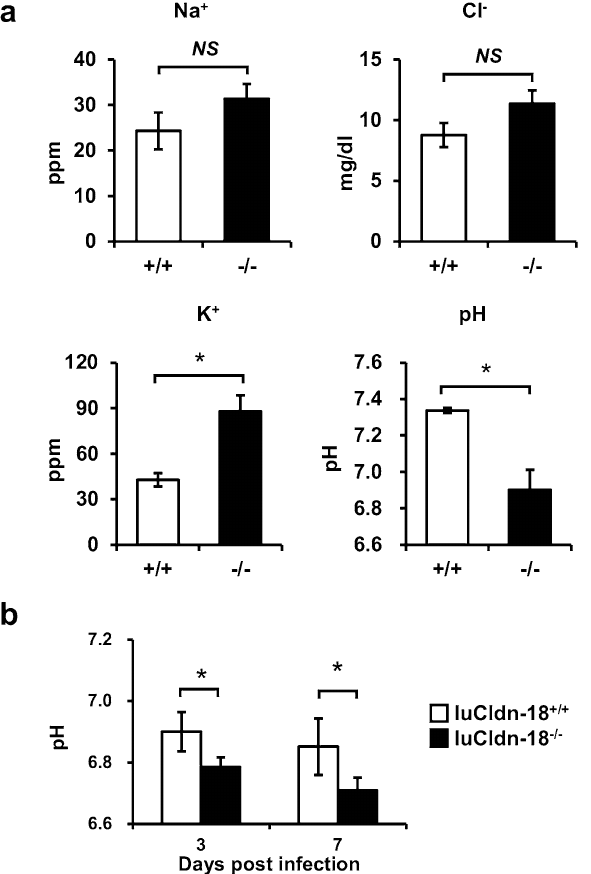
Figure 5. Effects of luCldn-18 deficiency on ion concentration and pH in BALFs. ( a ) The concentrations of several ions (Na + , Cl − , K + ) and pH were measured in BALFs of uninfected luCldn-18 +/+ (n = 3) and luCldn-18 −/− mice (n = 3) . Each column represents the mean ± SD. ( b ) luCldn-18 +/+ (n = 4) and luCldn-18 −/− mice (n = 4) were infected intratracheally with C. deneoformans. pH in BALFs was measured on day 3 and 7 post-infection. Each column represents the mean ± SD. *, p < 0.05. NS , not significant. There were no mice excluded from this